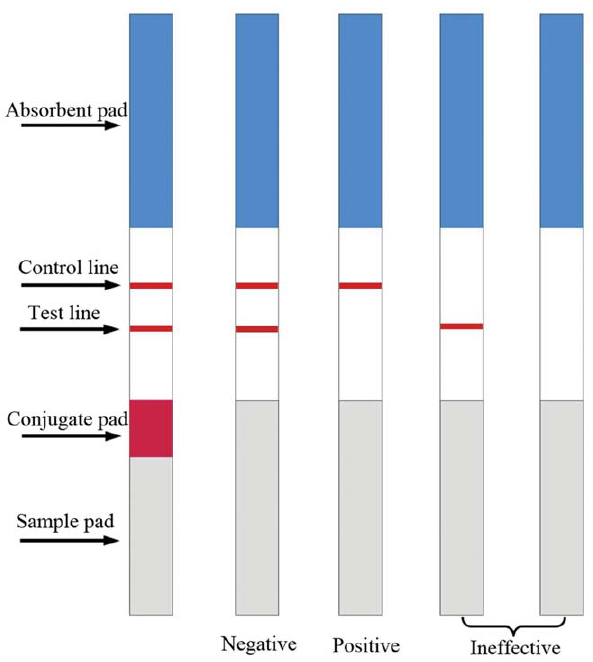
Figure 2. Schematic diagram of ICA test strip and result judgment. The ICA test strip was composed of the NC membrane, MAb-gold-conjugated pad, sample pad and absorbent pad, which were pasted onto an adhesive plastic backing. Result judgment was based on the color changed on the T and C line zone.